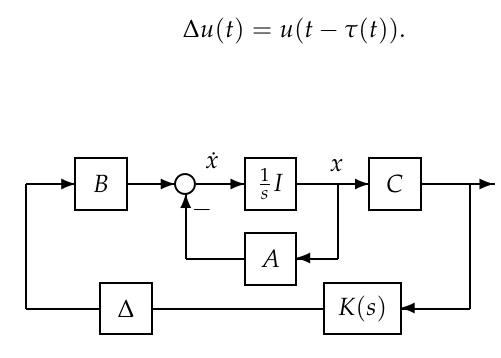
Figure 1. Feedback system with time-varying input